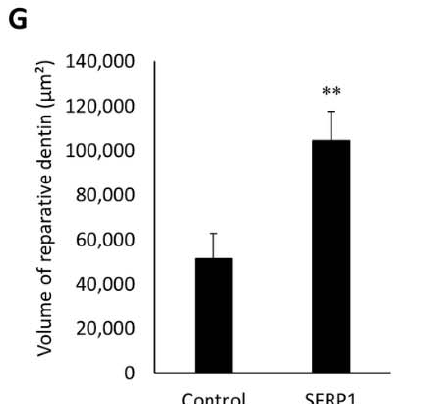
Figure 6. Effects of SFRP1 on reparative dentin formation after direct pulp capping treatment. ( A ) Images of HE-stained maxilla first molars from 10-week-old male Wistar rats after 2 weeks of direct pulp capping treatment. Representative images of specimens applied with nano β -TCP collagen scaffolds containing 0 ( a – c ) or 200 ng ( d – f ) rhSFRP1. ( b , e ) Higher magnification images of white boxes in ( a , d ). ( c , f ) Higher magnification images of white boxes in ( b , e ). Dotted lines indicate a border between primary dentin and newly formed reparative dentin. Immunohistochemical staining for anti-Nes ( B ) and rabbit control IgG ( C ) antibodies in the serial sections of ( A ). These images are higher magnifications of the areas in the white boxes in ( c , f ). ( D ) Images of HE-stained maxilla first molars from 12-week-old male Wistar rats after 4 weeks of direct pulp capping treatment. ( b , e ) Higher magnification images of white boxes in ( a , d ). ( c , f ) Higher magnification images of white boxes in ( b , e ). Dotted lines indicate a border between primary dentin and newly formed reparative dentin. Black arrows indicate embedded dental pulp cells in generated bone-like dentin. White arrows indicate dentinal tube-like structures in reparative dentin. Immunohistochemical staining for anti-Nes ( E ) and rabbit control IgG ( F ) antibodies in the serial sections of ( D ). These images are higher magnifications of the areas in the white boxes in ( c , f ). Representative images of five independent specimens treated with nano β -TCP collagen scaffolds containing 0 ( a ) or 200 ng ( b ) rhSFRP1. ( G ) The amount of newly formed reparative dentin in control and 200 ng rfSFRP1 groups after 4 weeks of direct pulp capping treatment. Data are shown as the mean ± standard deviation ( n = 5). ** p < 0.01. Bars = 100 µ m. rhSFRP1, recombinant human SFRP1; Dis, distal; Mes, mesial; D, dentin; P, dental pulp; RD, reparative